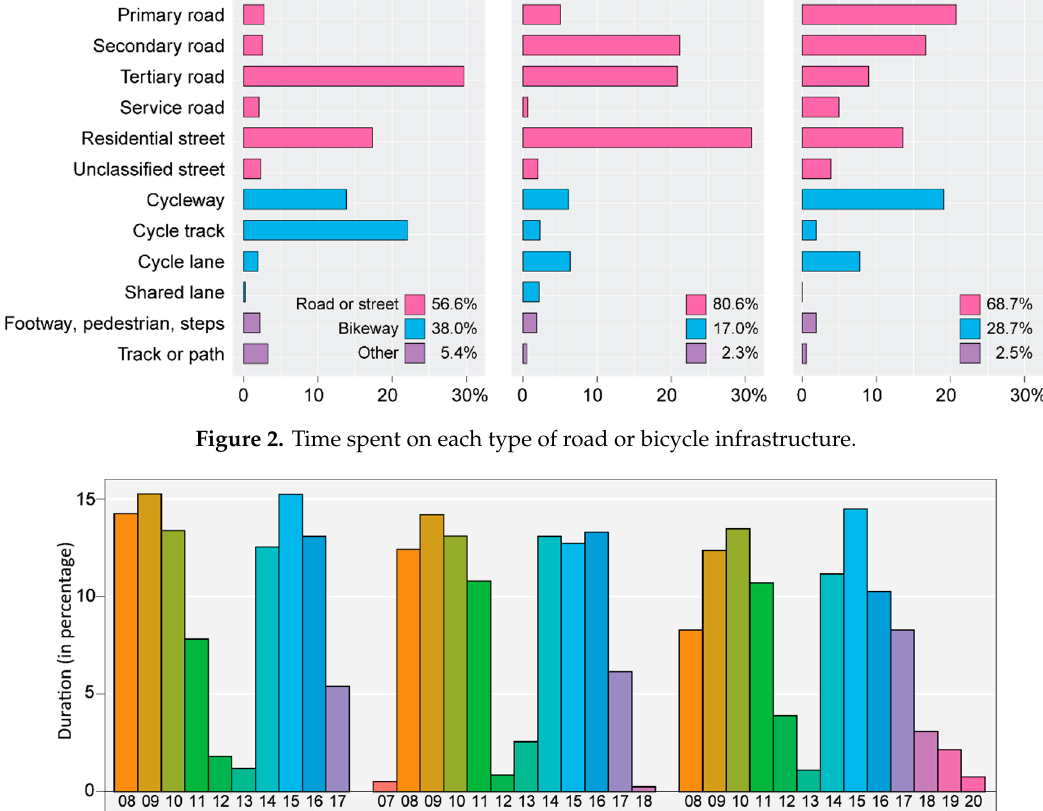
Figure 3. Time of data collection.